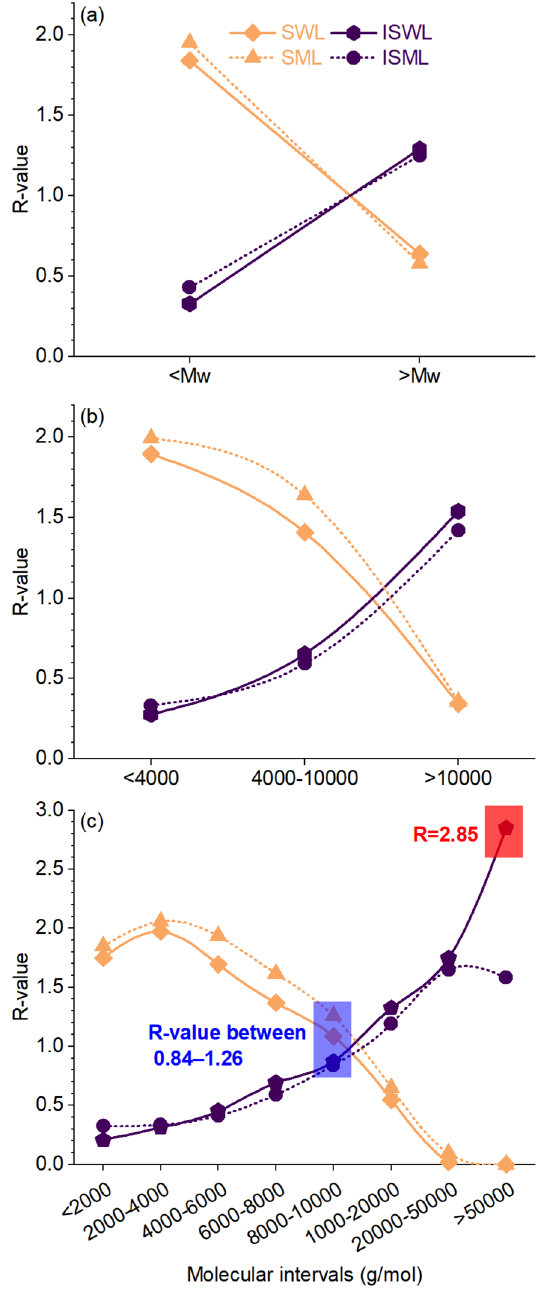
Figure 4. Ratio (R) between the yields of the fractions belonging to a certain molecular interval and the yield of fraction: R under ( a ) 2, ( b ) 3, and ( c ) 8 intervals; Mw was 5653 for WL and 6553 for